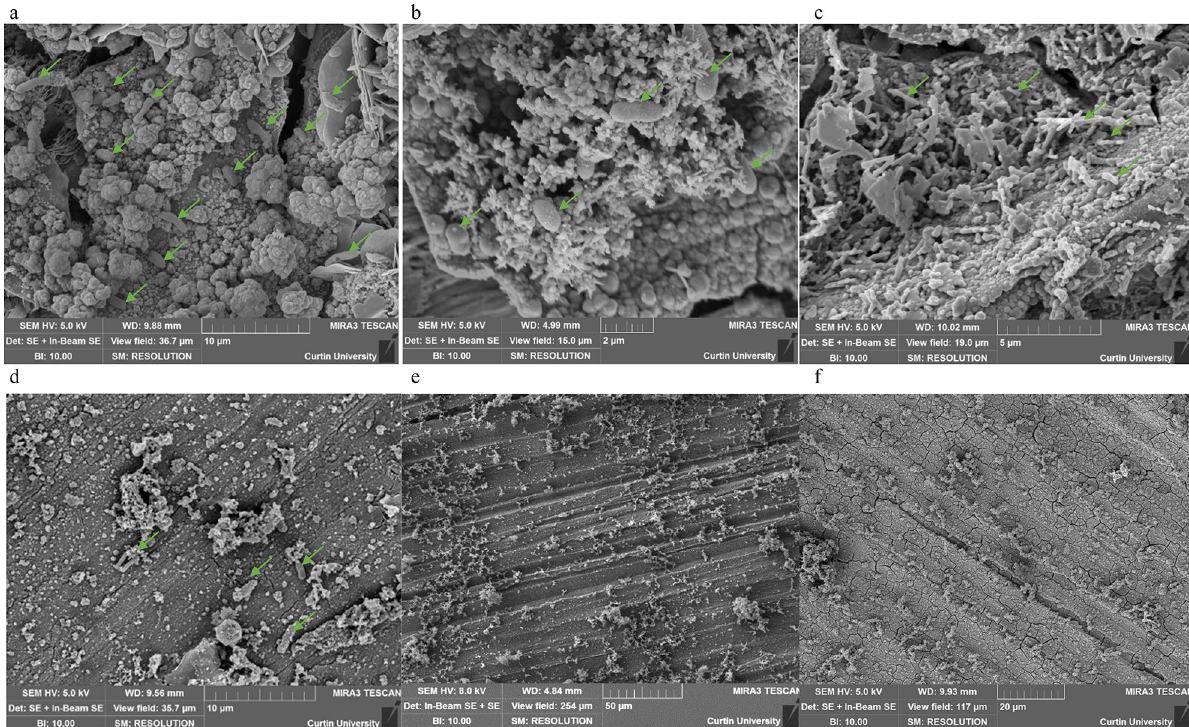
Figure 5. Representative SEM micrographs of oxidised and wet-ground control surfaces. Arrows indicate structures resembling bacterial cells. Micrographs ( a – c ) represent S. chilikensis , K. pneumoniae and P. balearica attached to oxidised surfaces respectively. Micrographs ( d – f ) represent the isolates attached to wet-ground surfaces.